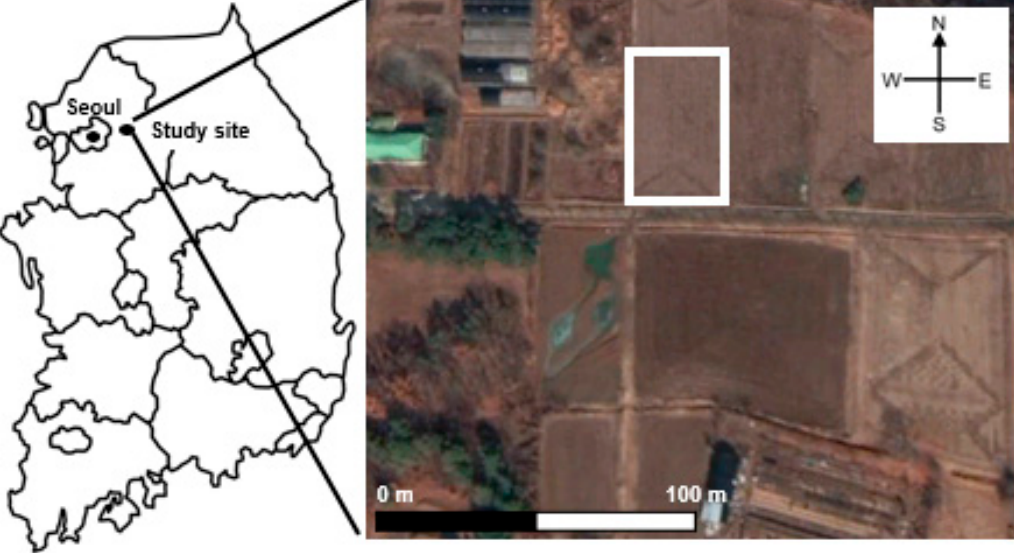
Figure 1. Satellite view (Google Earth Pro, 2020) of the study site (outlined in white) and neighboring fields.